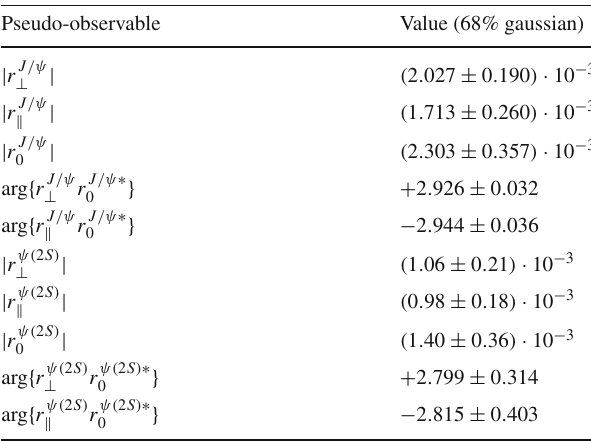
Table 3 Pseudo-observables from B → K ∗ ψ n